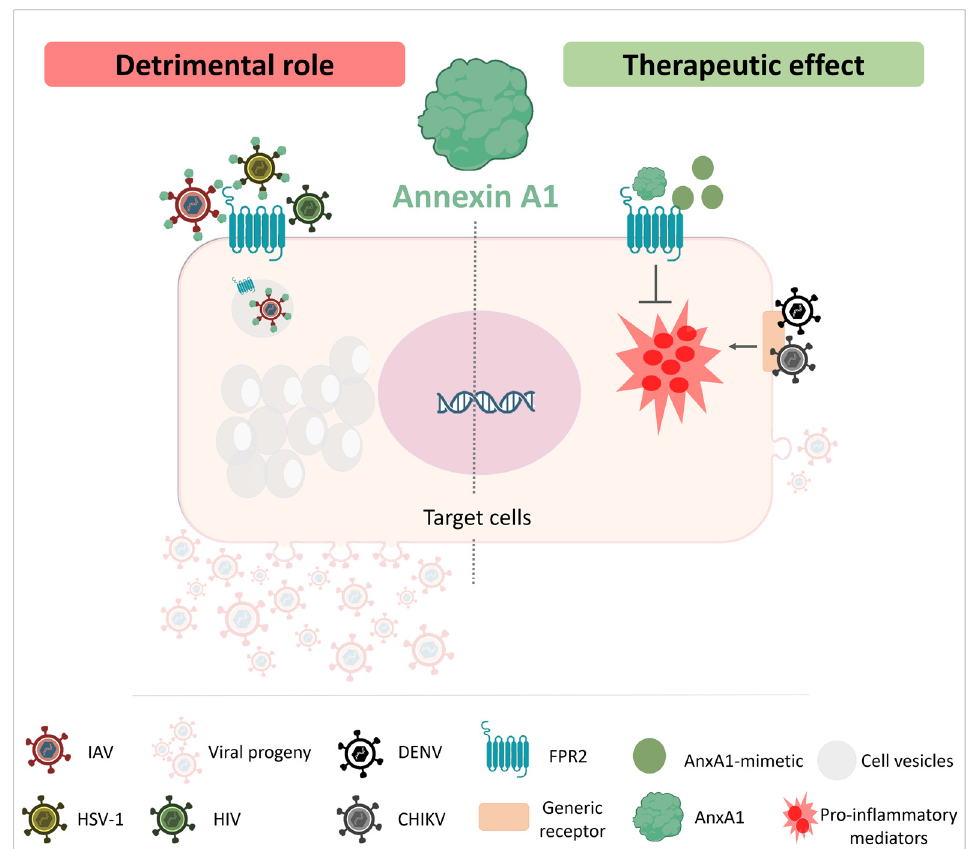
Figure 2. The multifaceted role of Annexin A1 in viral infections. In the left part of the figure, viral infections in which endogenous AnxA1 plays a deleterious role are represented, such as increasing virus endocytosis and intervening with different mechanisms in the cell cytoplasm that favor viral replication. Viruses such as IAV and HSV-1 use FPR2 as a co-receptor, with AnxA1 adsorbed in their viral particles. Conversely, HIV did not depend on AnxA1 to use FPR2 as a co-receptor. In the right part of the panel, viral infections in which AnxA1 or its mimetic peptides play a bene fi cial role are represented, such as for CHIVK and DENV, decreasing the production of pro-in fl ammatory mediators and exuberant in fl ammation in a general way, without altering the capacity of the host to deal with viral replication.